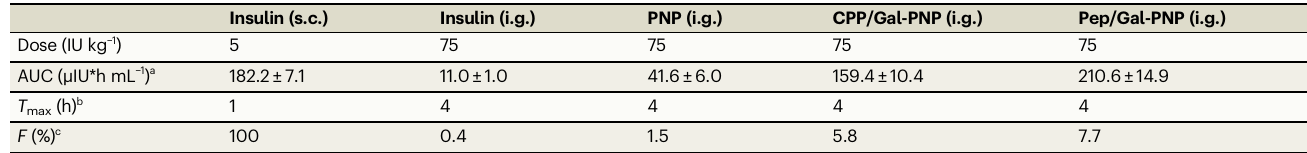
a AUC:area under theperipheral seruminsulin level versus time curve; b T max : timeat which the maximumplasma insulin level was reached; c F : relative bioavailability. s.c., subcutaneous; i.g., intragastric(oral). Data arepresented as the mean±SD( n